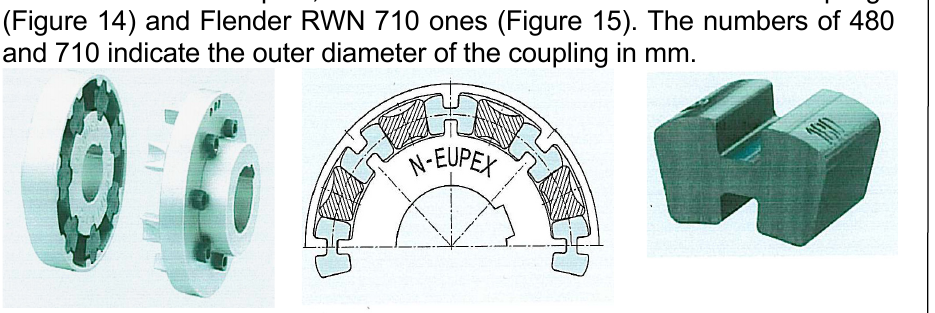
Figure 14 – Flexible coupling type Flender N-EUPEX version A 480 Рисунок 14 – Эластичная муфта Флендер N-EUPEX тип А 480 Слика 14 – Еластична спојница типа Flender N-Eupex, изведба A